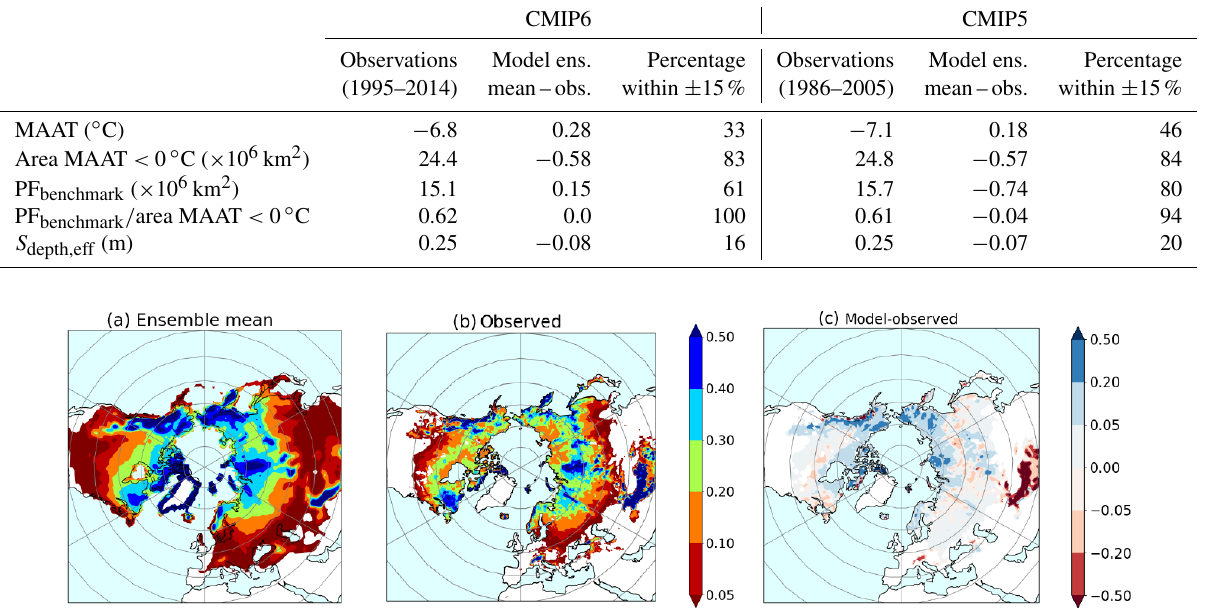
Figure 5. S depth,eff for 1999–2014 for the multi-model ensemble mean of the CMIP6 models (a) compared with the CMC observations (b) . (c) The differences between the multi-model ensemble mean and the observations. All grid cells with S depth,eff less than 0.02m are